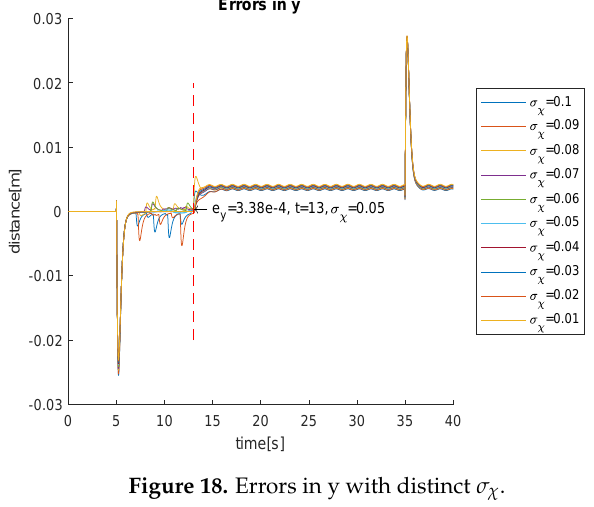
Figure 17. Errors in x with distinct σ χ .